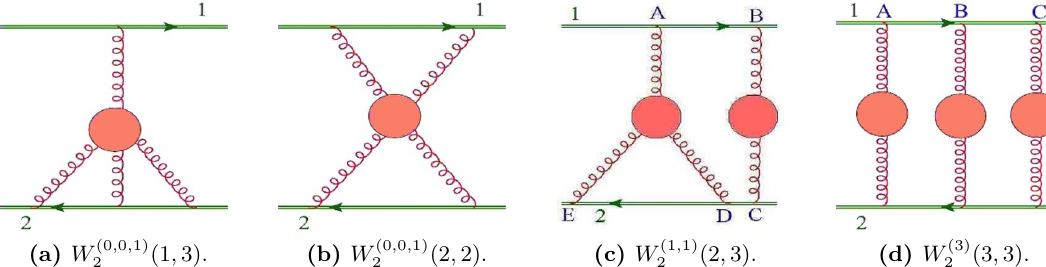
Figure 1. Representative skeleton diagrams for the four three-loop Cwebs connecting two Wilson lines in a massless theory. As clarified in the text, the Cwebs in (a) and (b) have only one diagram, displayed here, while the Cwebs in (c) and (d) have six